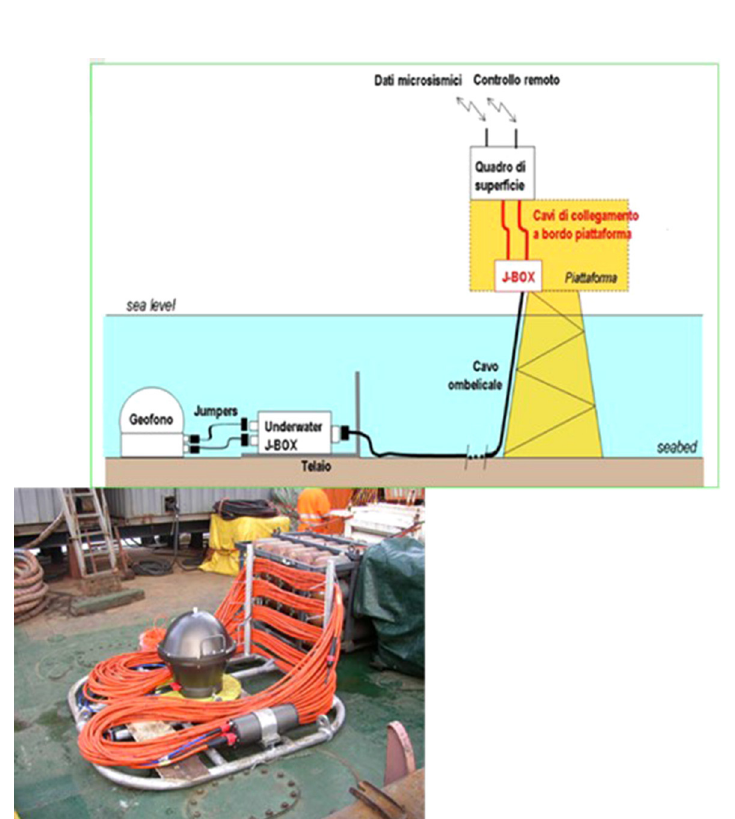
Fig. 20. – Schematic view of an offshore micro seismic station (top) and photograph of the underwater sensor